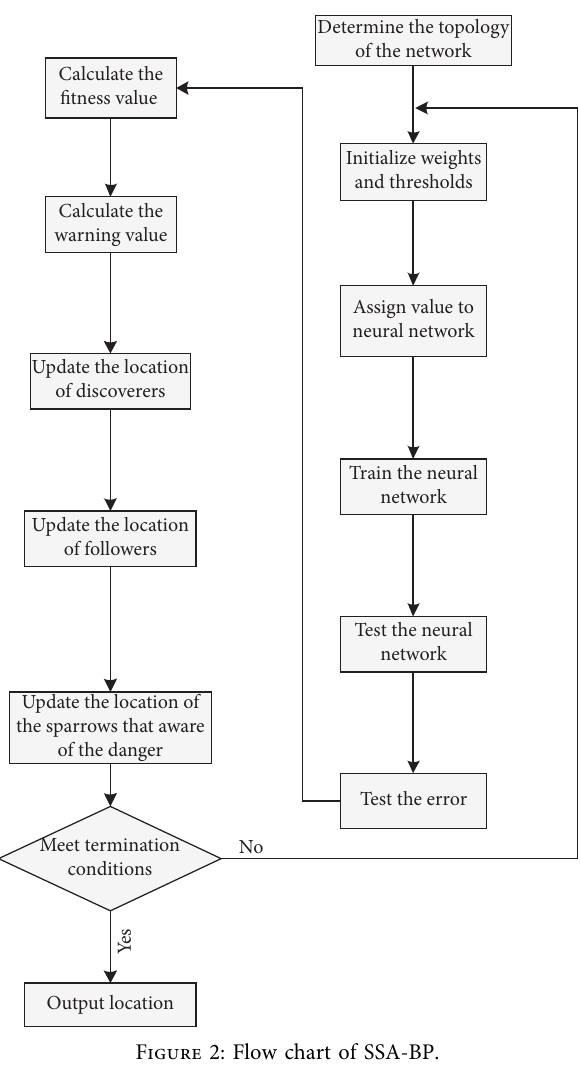
Figure 2: Flow chart of SSA-BP.